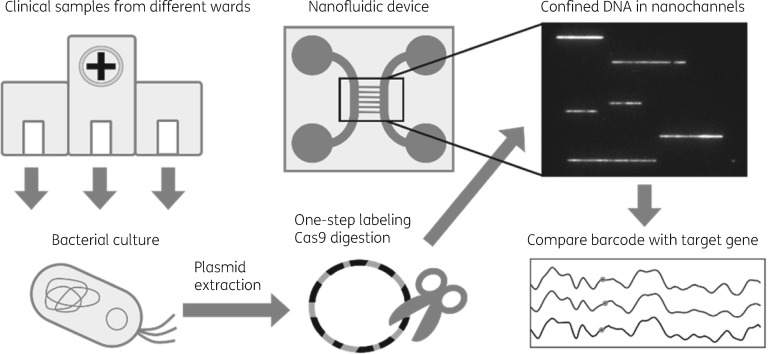
Schematic overview of ODM for plasmid characterization. Clinical samples were collected from three different wards in an Ethiopian hospital. Bacteria were cultured and the plasmids extracted. The plasmids were treated with CRISPR/Cas9 to create site-specific breaks at the gene of interest. This creates uniform, linearized DNA molecules that were then stained with YOYO-1 and netropsin to generate sequence-correlated fluorescence intensity profiles along the DNA, termed DNA barcodes. The barcodes are unique for every plasmid and can be used as a fingerprint to investigate transmission of plasmids by comparing barcodes of plasmids from different patients.